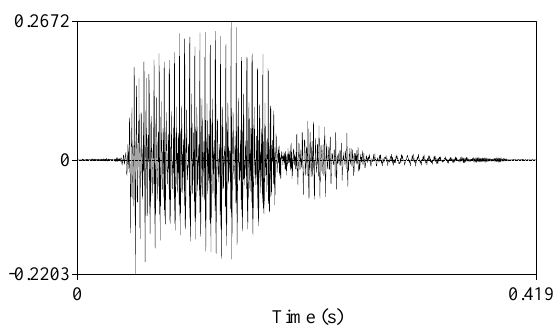
Figure 1. An audio signal corresponding to the Spanish audio “cero” (0).